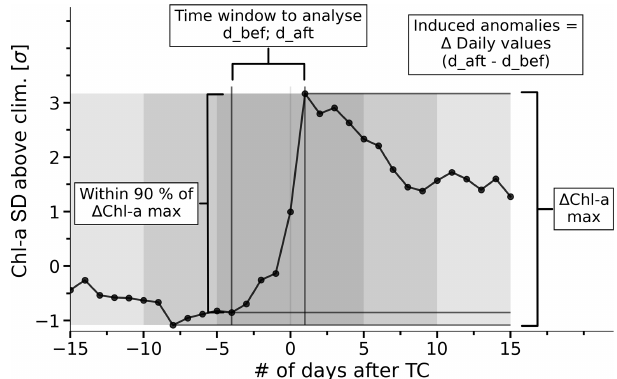
Figure 2. Schematic of the applied methodology for each TC. Black line shows the number of standard deviations from the climatolog- ical values for the area surrounding Hurricane Nadine. A detailed description of this methodology can be found in the